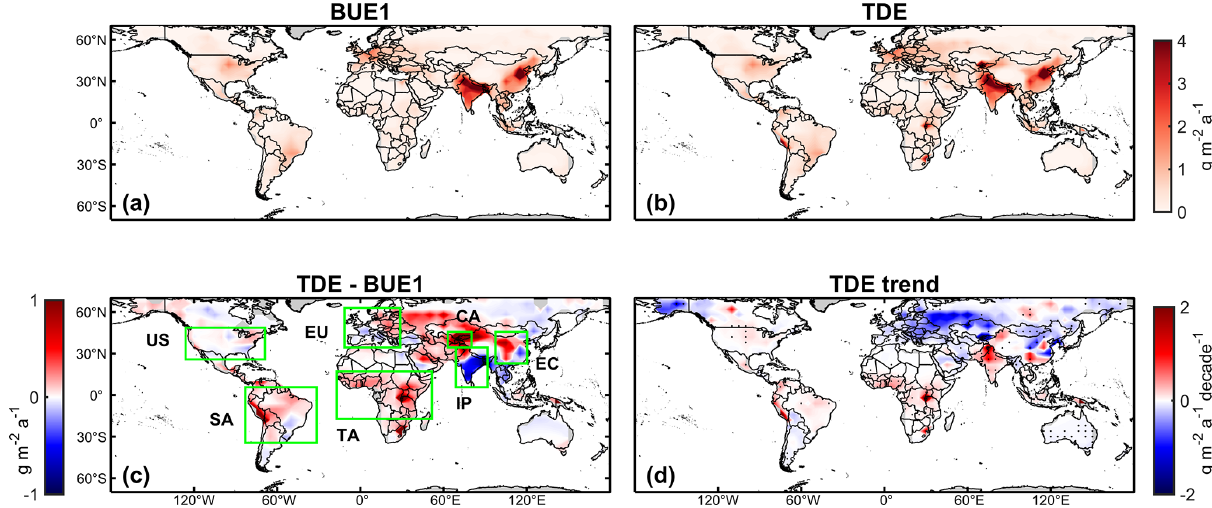
Figure 2. Spatial distribution of NH 3 emission fluxes during 2008–2018, showing (a) bottom-up emissions (BUE1) and (b) top-down emissions (TDE) inferred from IASI observations, (c) the difference between TDE and BUE1 estimates, and (d) emission trends derived from TDE estimates. Green boxes denote the seven regions analyzed in Sect. 3.2. Top-down emission fluxes are computed with Eq. (1) except for IP and EC for which Eq. (3) is applied. Linear trends are computed from the time series of annual averages. The dots in panel (d) represent significant linear trends at the 95% confidence level.